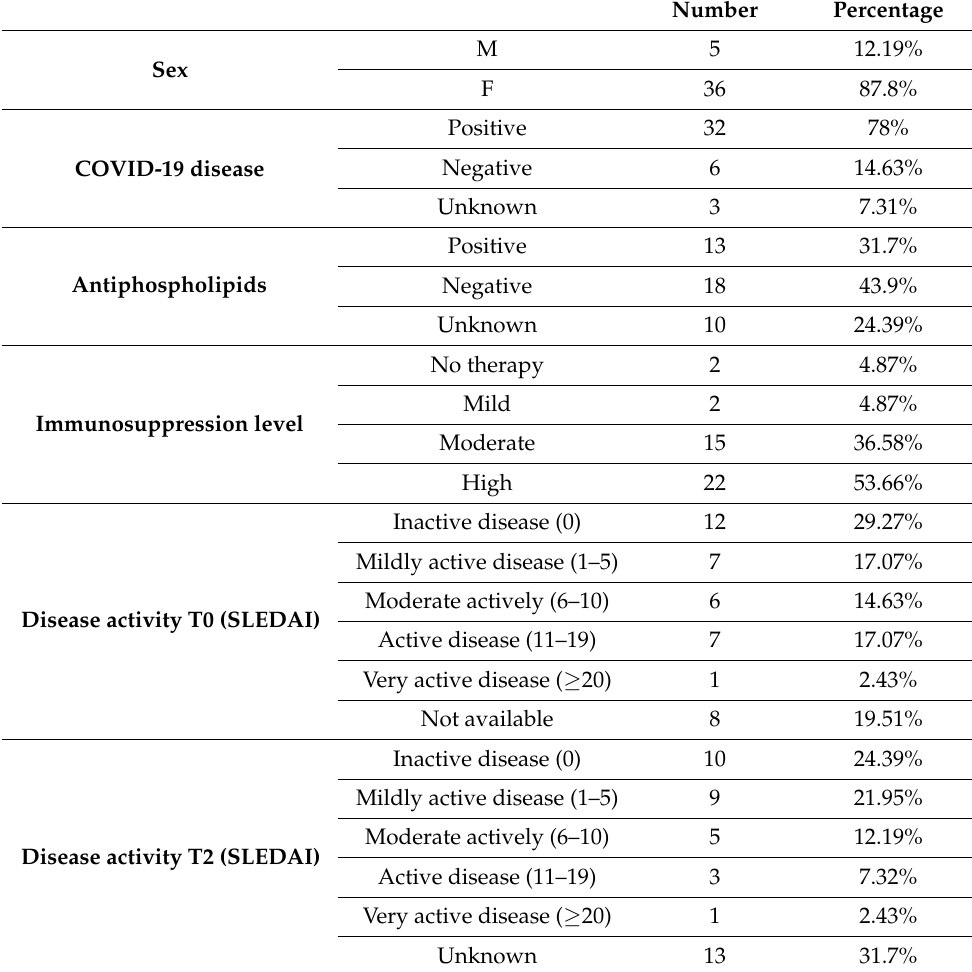
Table 1. Clinical features in our cohort of patients with systemic lupus erythematosus ( n =